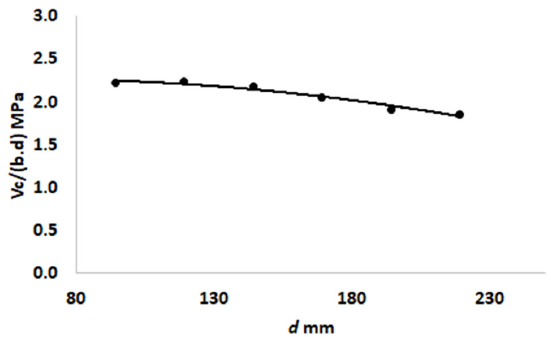
Figure 14. The effect of effective depth d of the beam on concrete shear strength.